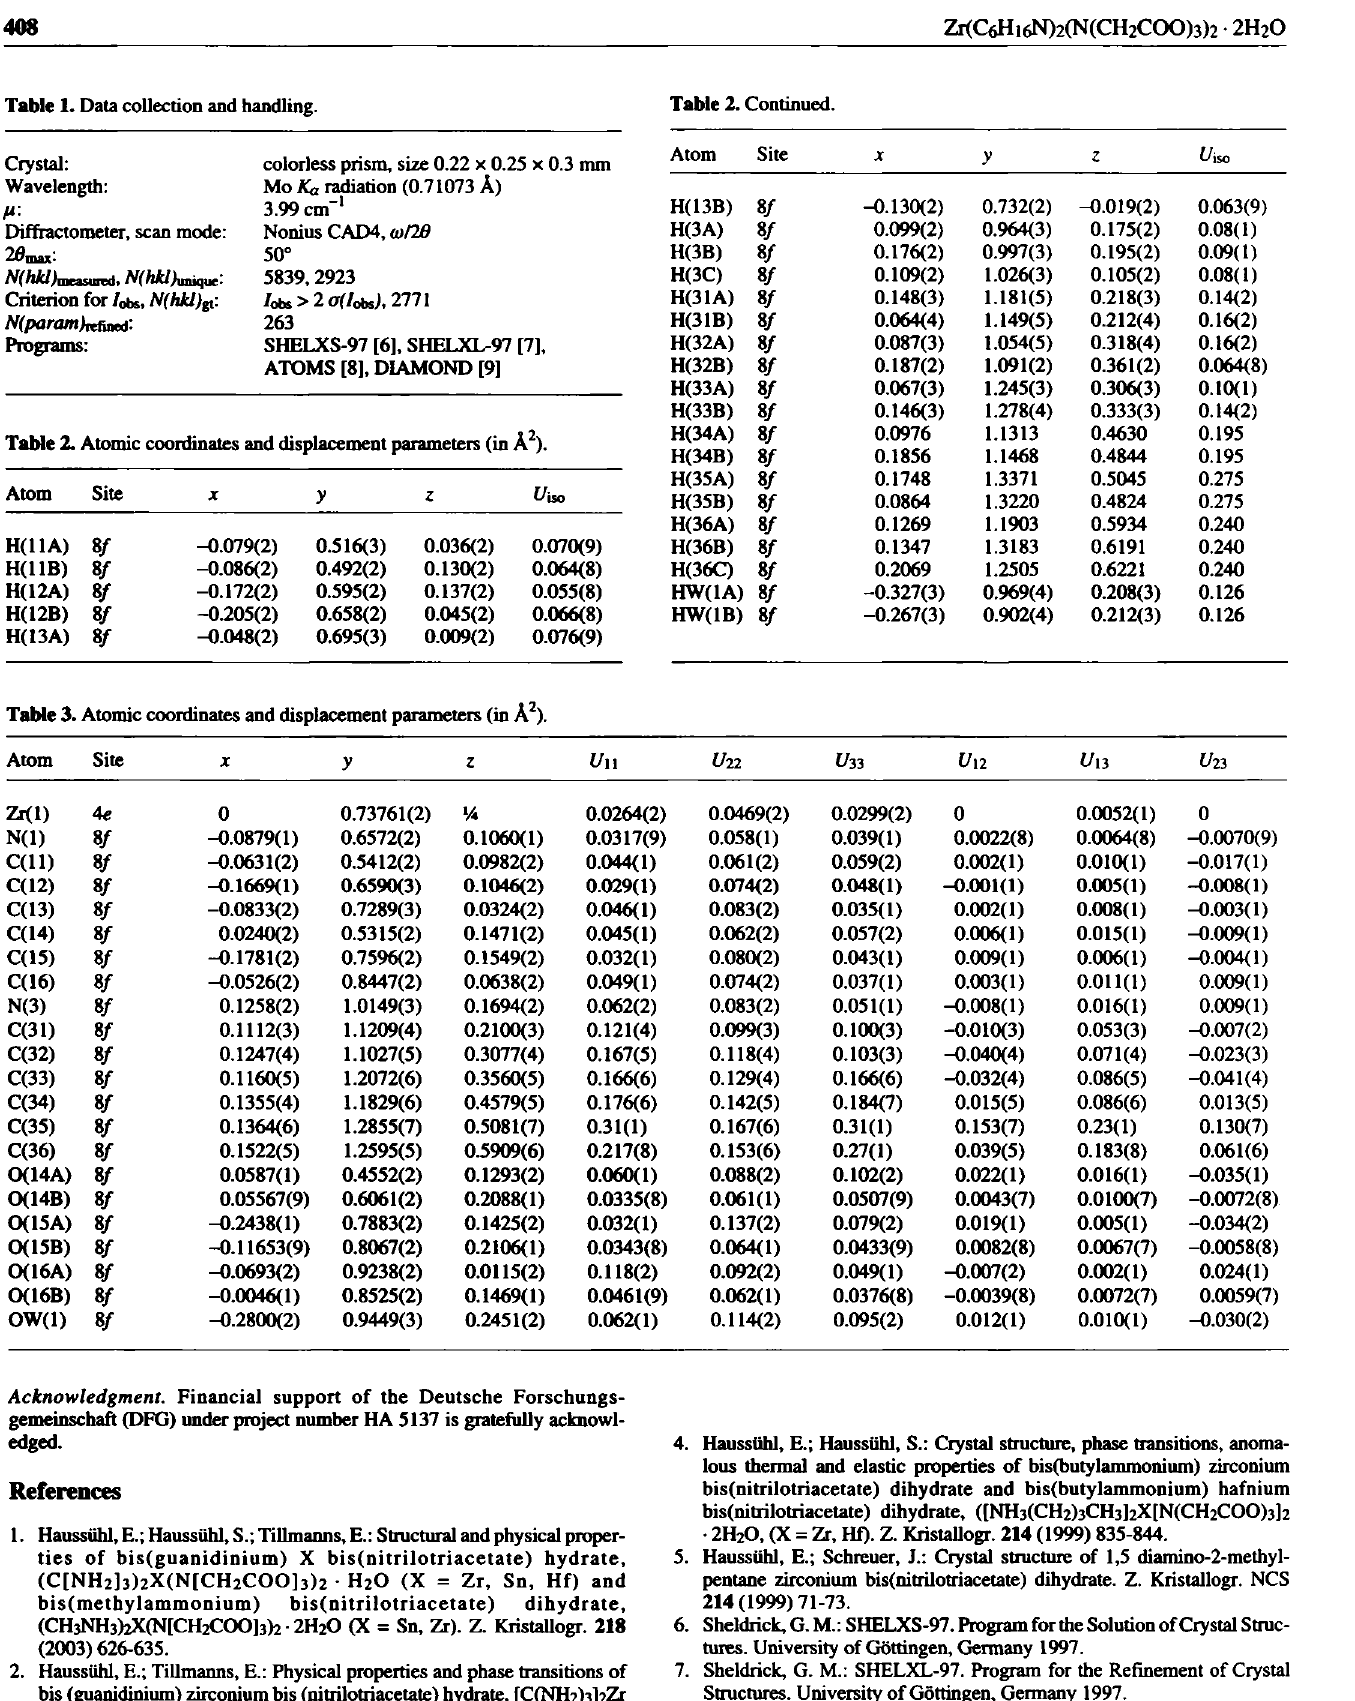
Table 1. Data collection and handling.